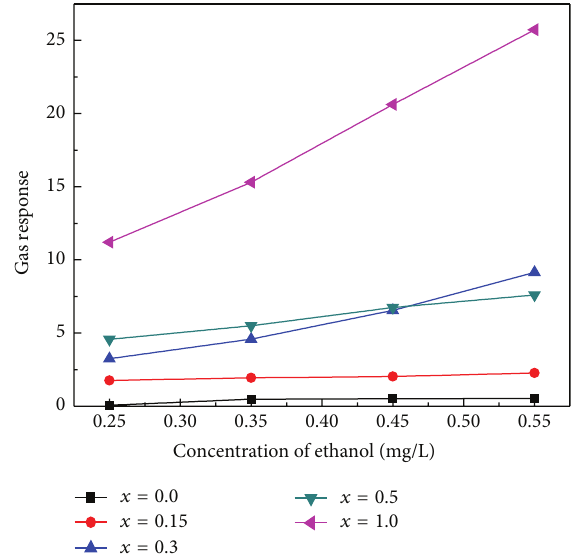
Figure 8: Ethanol concentration dependence of response of La 1−𝑥 Nd 𝑥 FeO 3 at 182 ∘